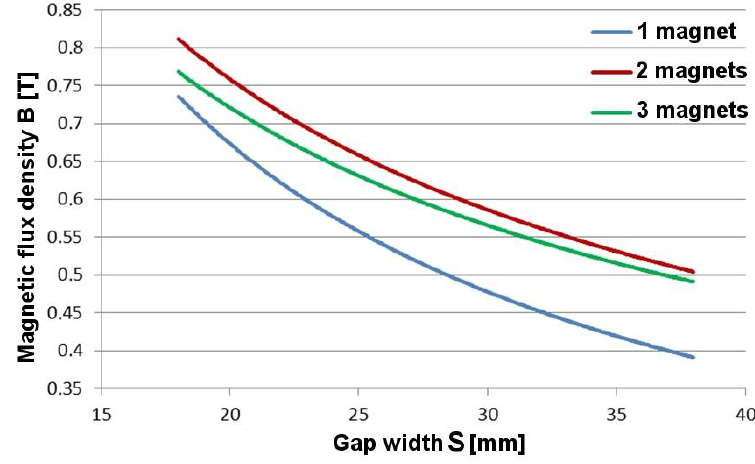
Figure 13. Impact on the magnetic flux density in the center of machining gap depending on the machining gap width and number of magnets, obtained from measurements.